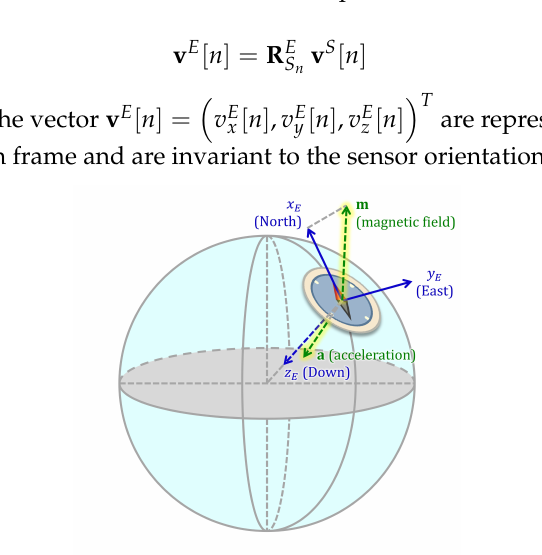
Figure 3. The Earth frame illustrated on an Earth model with the acquired reference vectors.